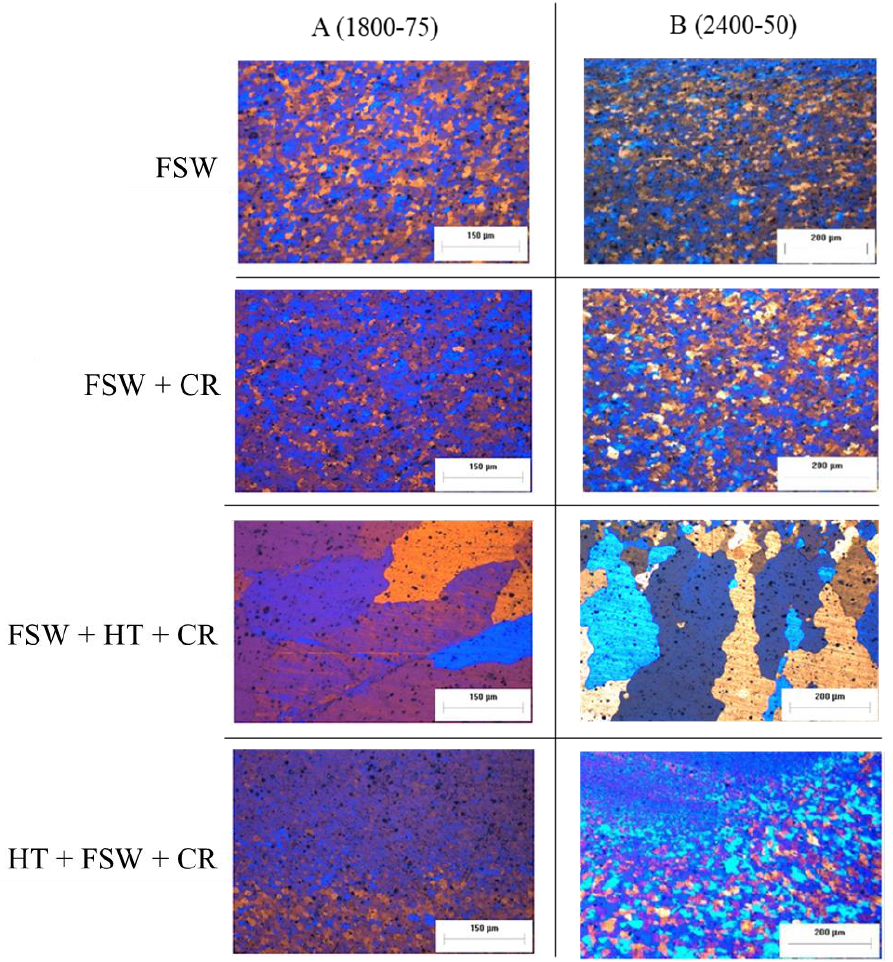
Figure 6. Comparison of POM taken in the nugget zone.